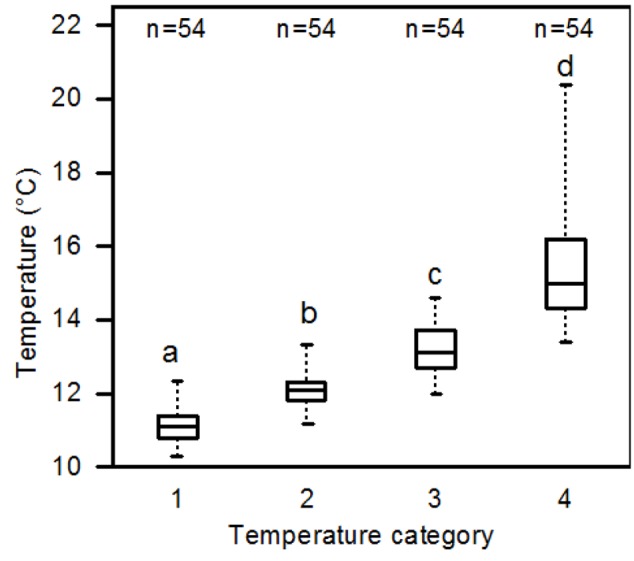
Median soil temperatures recorded in the temperature categories #1 to #4 which represent the 4 quartiles of the 36 measuring points in a plot (#1: the 25% coldest temperature values, #4: the 25% warmest temperature values) (all six plots pooled; afternoon measurements taken on August 1, 2012, at 10 cm depth). All four categories differed significantly form each other (p < 0.05; Mann–Whitney U test).